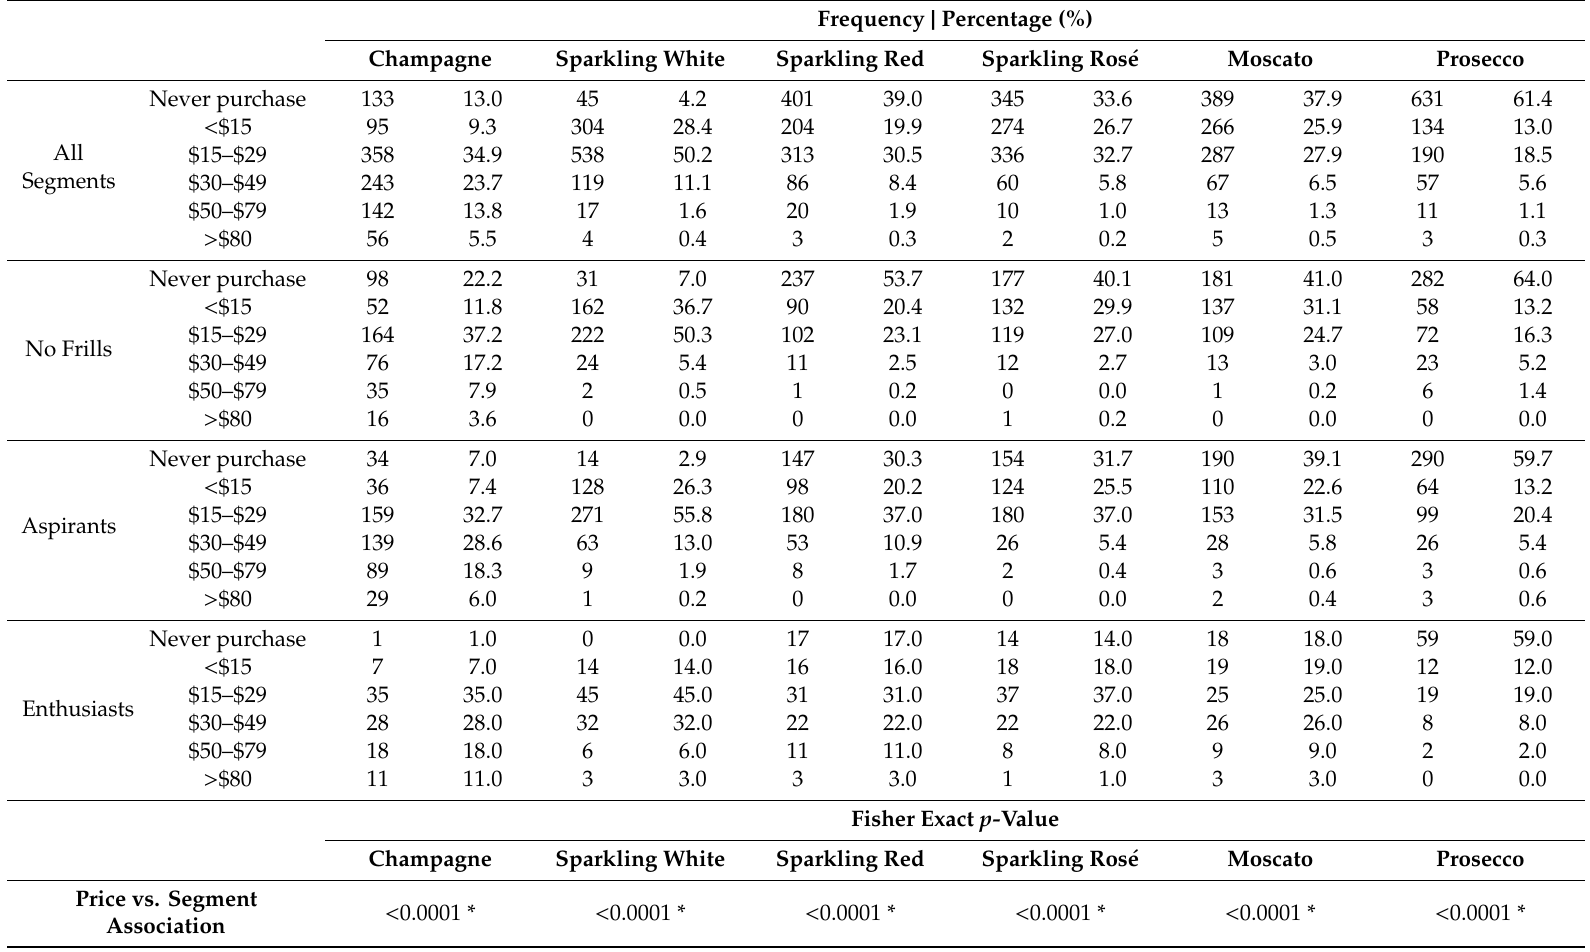
Table 8. Typical spending (AUD per bottle) of Fine Wine Instrument consumer segments on di ff erent sparkling wine